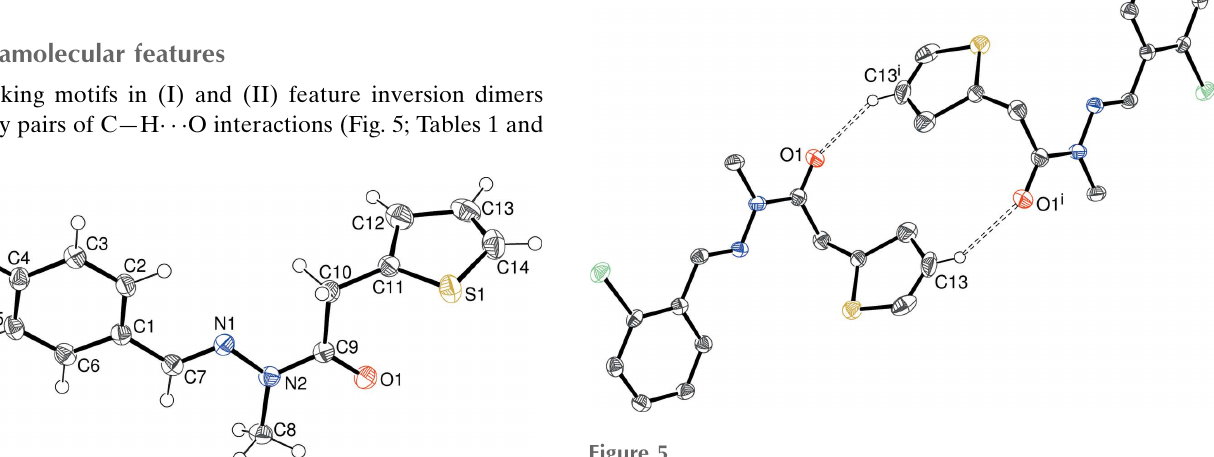
Figure 5 An inversion dimer in the crystal of (I) linked by a pair of C—H (cid:2)(cid:2)(cid:2) O interactions. [Symmetry code: (i) (cid:3) x , (cid:3) y , 1 (cid:3) z .] All H atoms except H13 have been omitted for